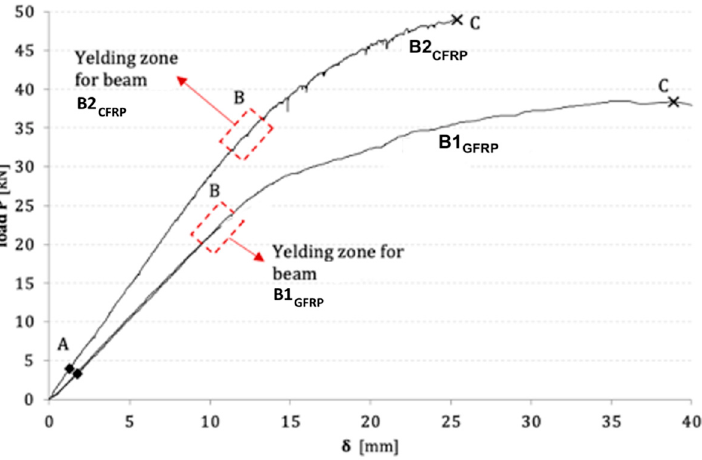
Figure 8. Experimental envelope diagrams load, P , vs. de fl ection at midspan, δ , of strengthened